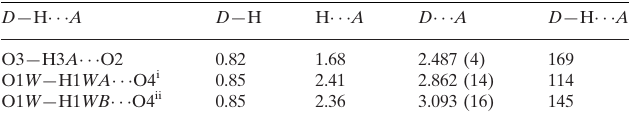
Hydrogen-bond geometry (A˚ , (cid:3) ). D —H (cid:2)(cid:2)(cid:2)